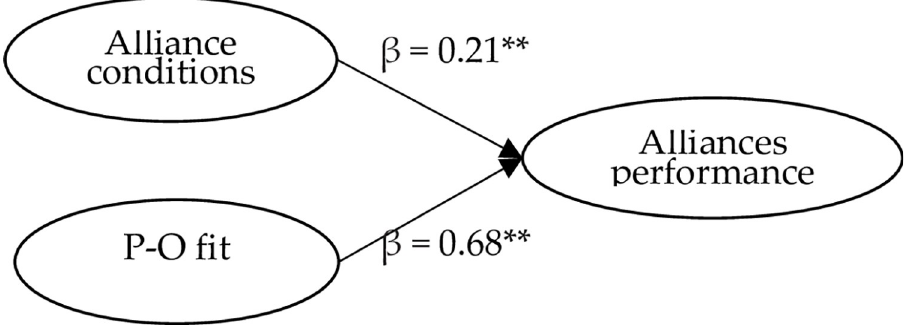
Fig 3. The main structural equation model diagram. �� p <